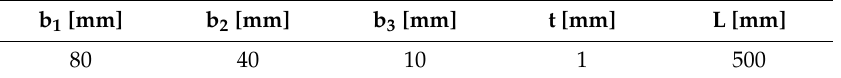
Figure 3. Cross-section of the LC beam. Table 1. Dimensions of the beam.